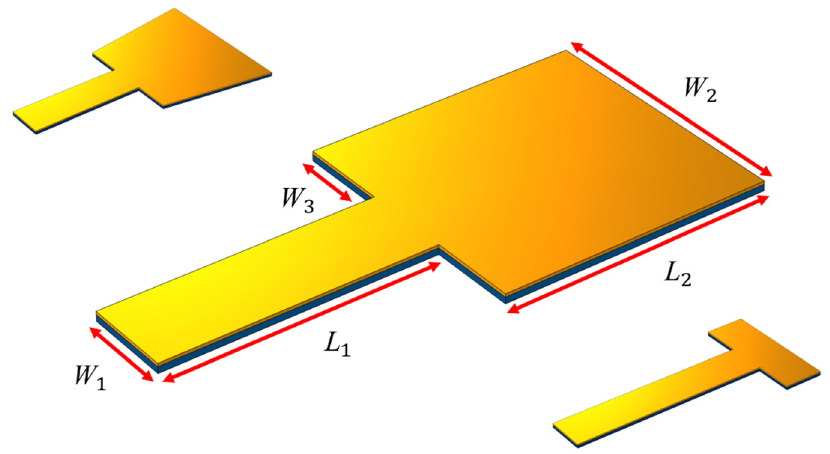
Figure 5. The schematic view of the studied two-step beam.